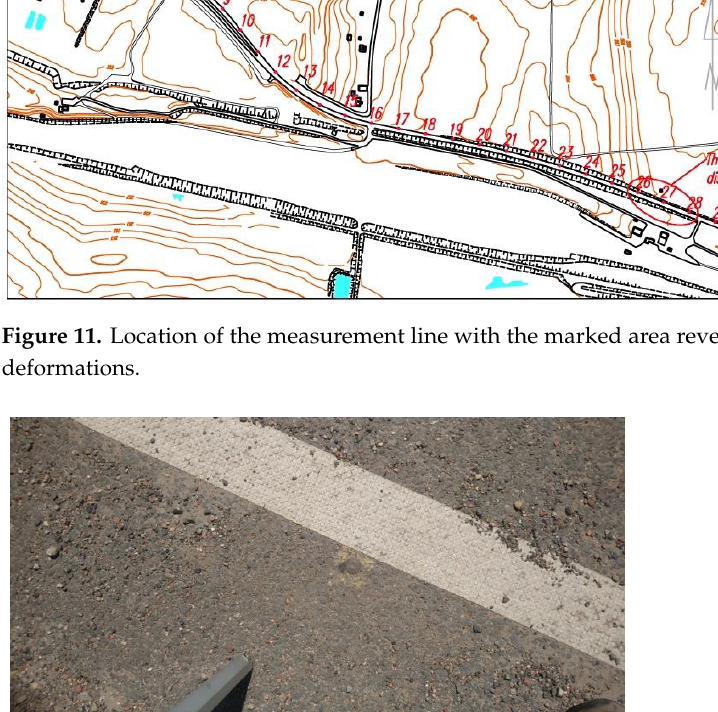
Figure 12. Stabilization of points along the right-of-way.